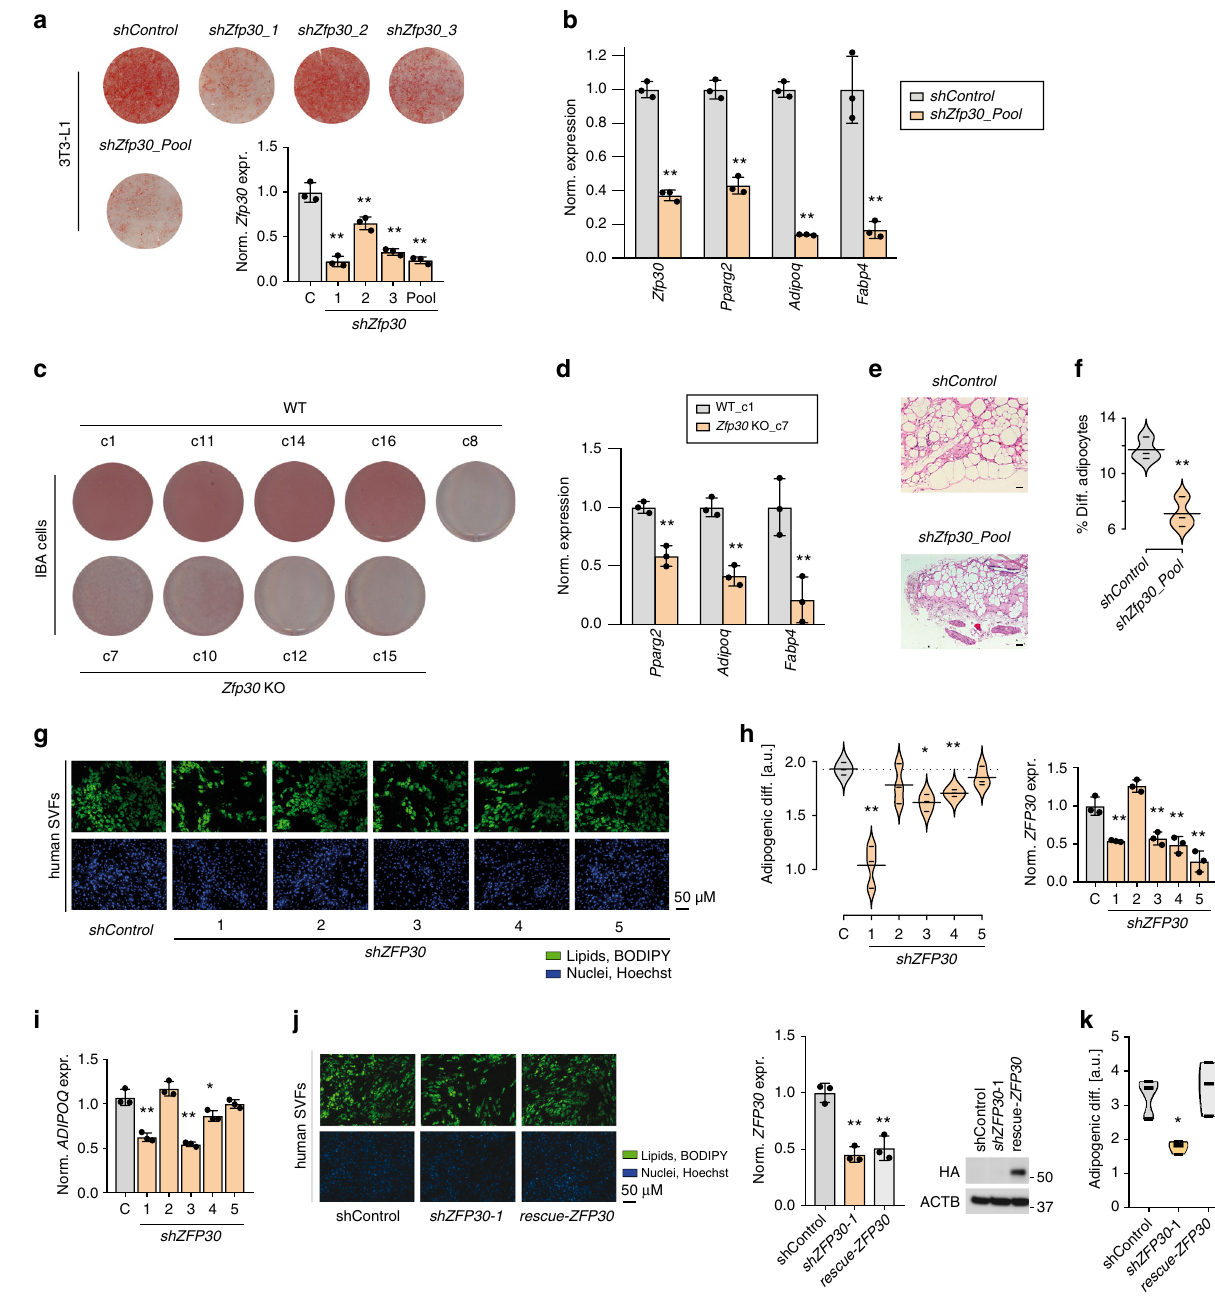
similarity, Supplementary Fig. 1J), with an almost identical fi ngerprint 10 (Supplementary Fig. 1K), we tested whether it also promotes adipogenesis in humans. We therefore isolated primary SVF cells from human lipoaspirate samples as previously described 36 and differentiated them with a hormonal cocktail, analogous to the mouse setup (see the Methods section). When ZFP30 levels were reduced by lentivirus-mediated shRNA, upon adipogenesis, we observed a signi fi cant ( p < 0.01, p < 0.05, paired t staining) (Fig. 1g, h) and adipogenic marker gene expression (Fig. 1i) for three out of the four shRNAs that successfully reduced ZFP30 expression. The observed difference was not driven by distinct proliferation rates, as overall cell numbers were comparable across differentiated samples (Supplementary Fig.